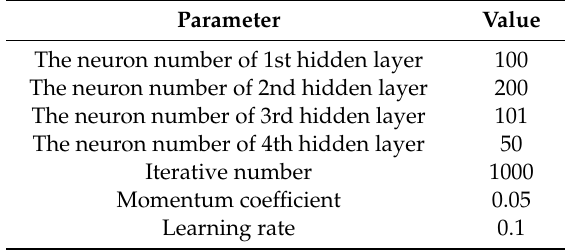
Table 5. The values of deep neural network (DNN) and deep transfer network (DTN)